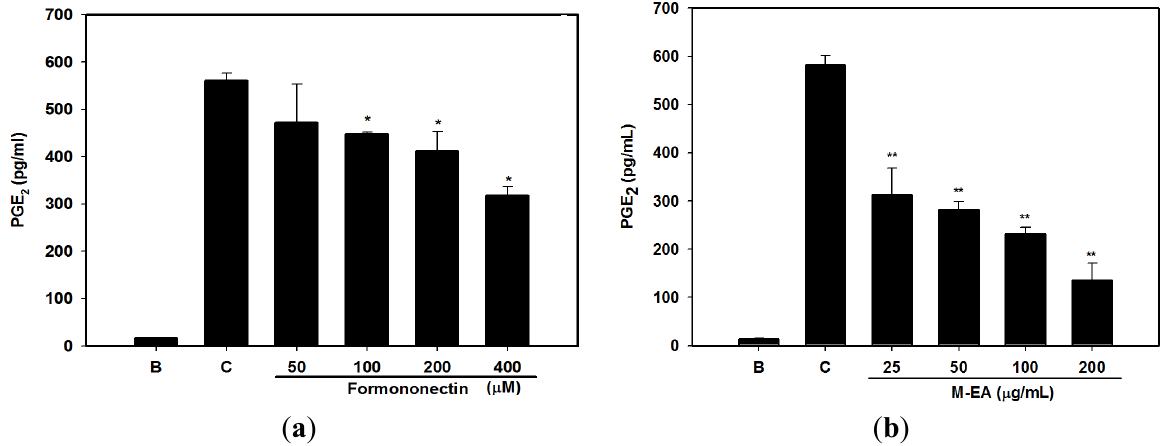
Figure 3. Dose responses of formononetin ( a ) and M-EA ( b ) on PGE LPS-activated RAW 264.7 cells. B: without LPS treatment, C: treatment with LPS and 0.2% DMSO. Values are presented as the mean ± SD, n = 3, each with triplicate samples. * p < 0.05, ** p <